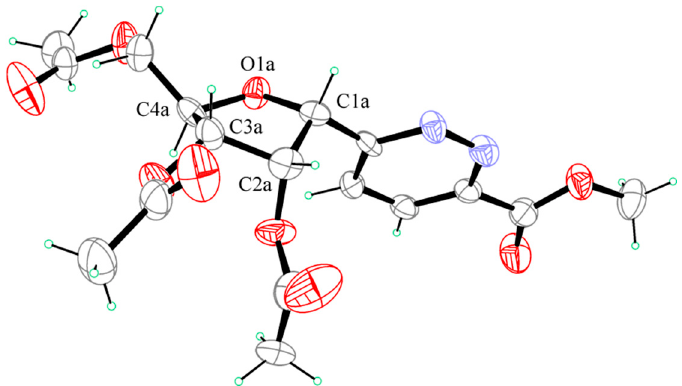
Figure 3. Molecular structure of 5d showing the α -configuration (Ortep view with ellipsoids drawn at 30% probability level).